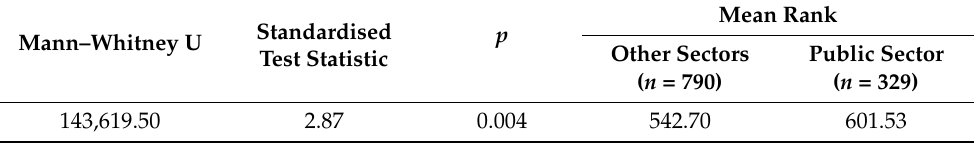
Table 7. Effect of activity sector on recognition agreement of public administration employees.